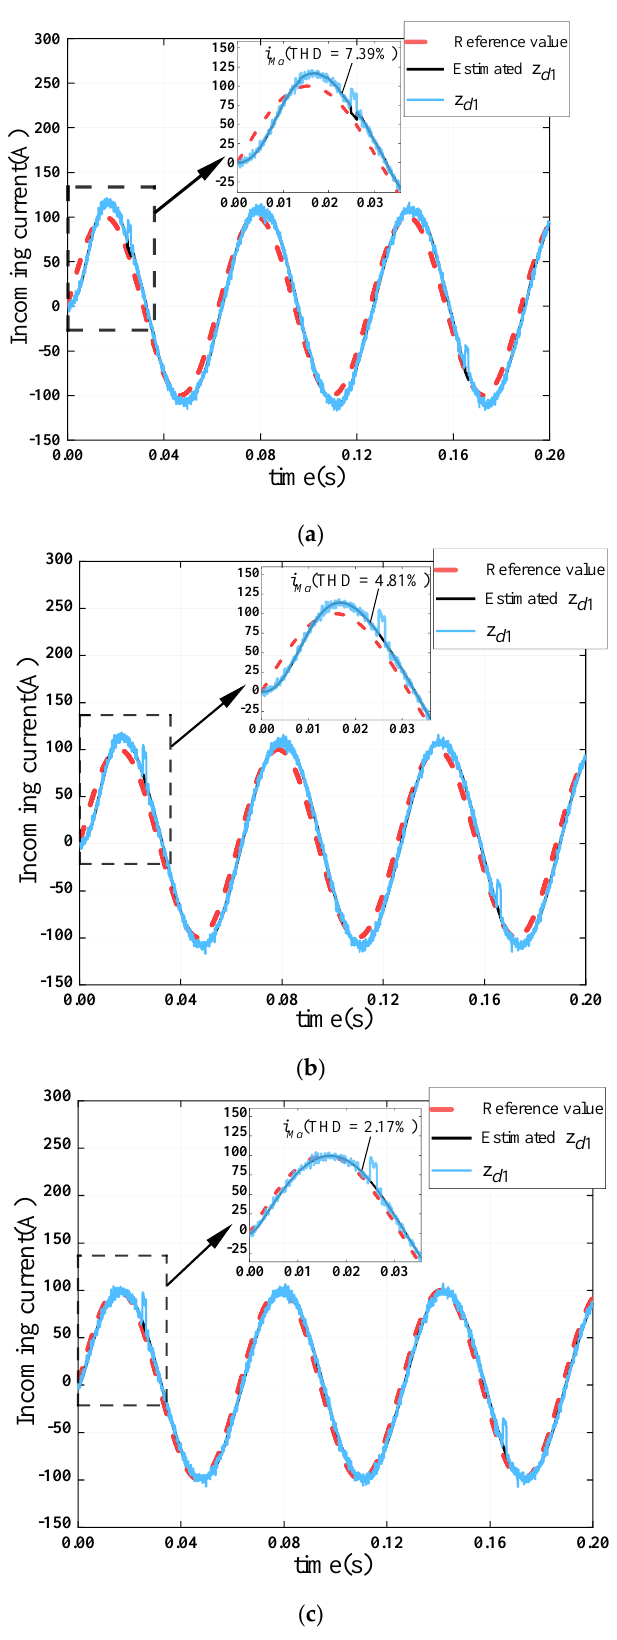
Figure 10. Transient tracking performance of current mutation current waveform: ( a ) double-loop PI control strategy; ( b ) classical LADRC strategy; ( c ) BS-LADRC